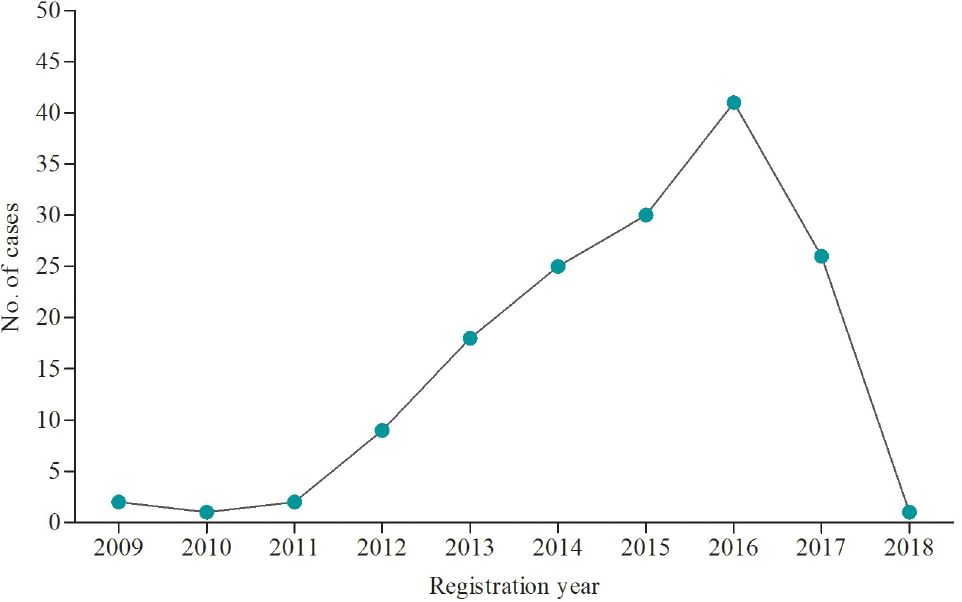
Fig 1. Drug resistant tuberculosis treatment enrollment trend in children, Ethiopia,